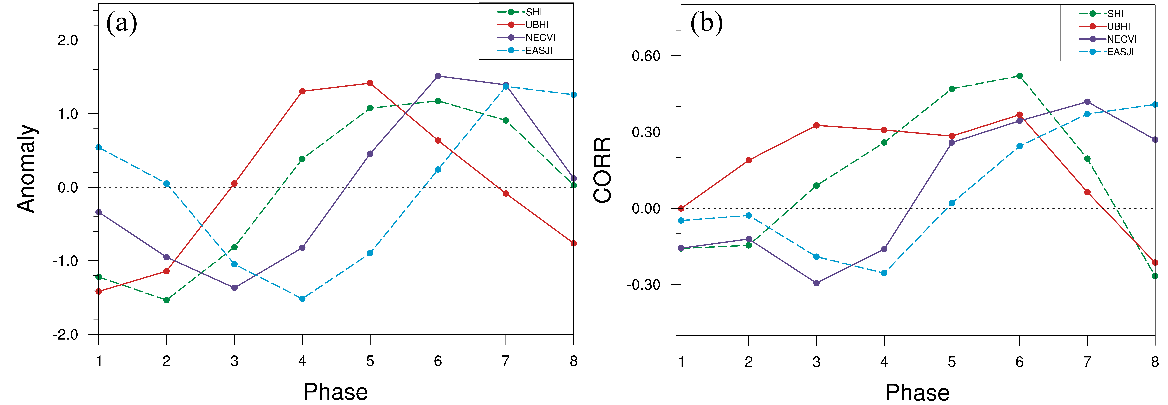
Figure 10. Phase evolution of ( a ) the strength indexes and ( b ) lead-lag correlation coefficients between strength indexes at phases 1–8 and (T min minus threshold) × ( − 1) at phase 7.